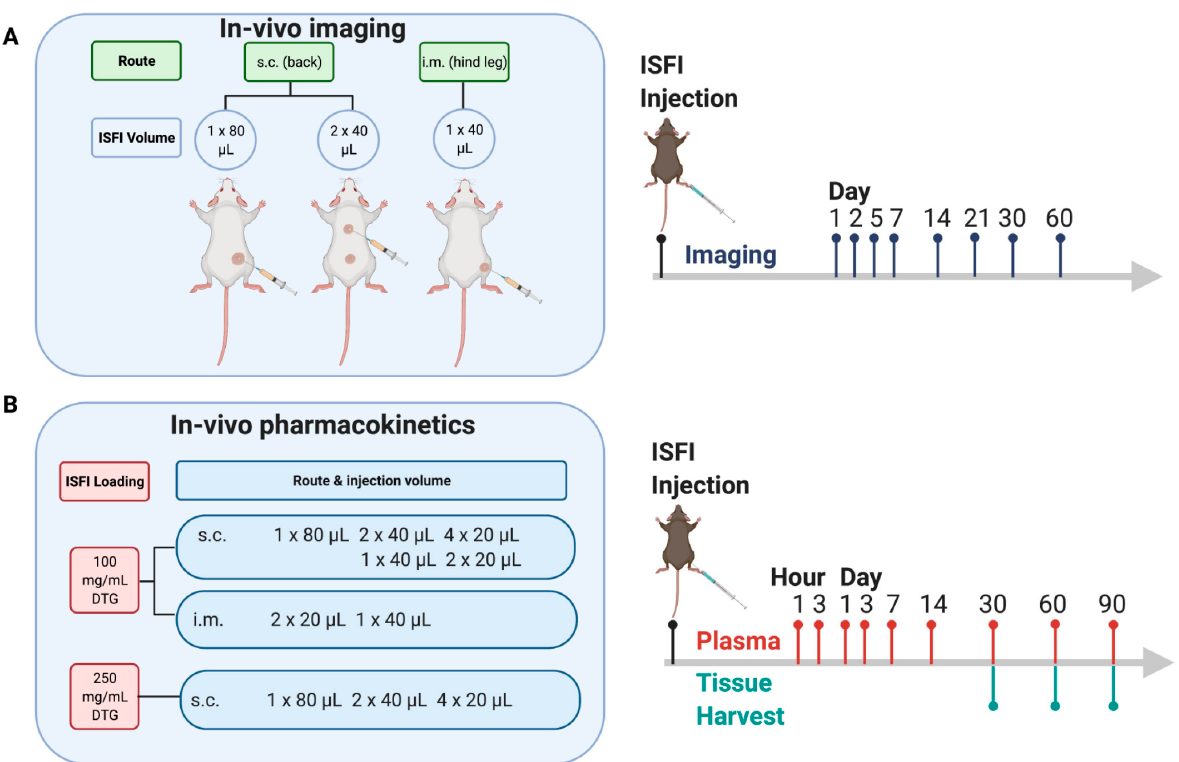
Figure 1. Study design to determine the effects of injection volume, number of injections and route of administration on ISFI degradation and drug release: ( A ) B mode ultrasound imaging of placebo ISFIs: SQ (1 × 80 μ L, n = 8 mice/group and 2 × 40 μ L, n = 5 mice/group) and IM (1 × 40 μ L, n = 10 mice/group). ( B ) Pharmacokinetic study of 100 mg/mL and 250 mg/mL DTG ISFIs injected via SQ and IM with varying number of injections and injection volumes ( n = 10 groups; n = 12 mice/group; n = 120 total mice).